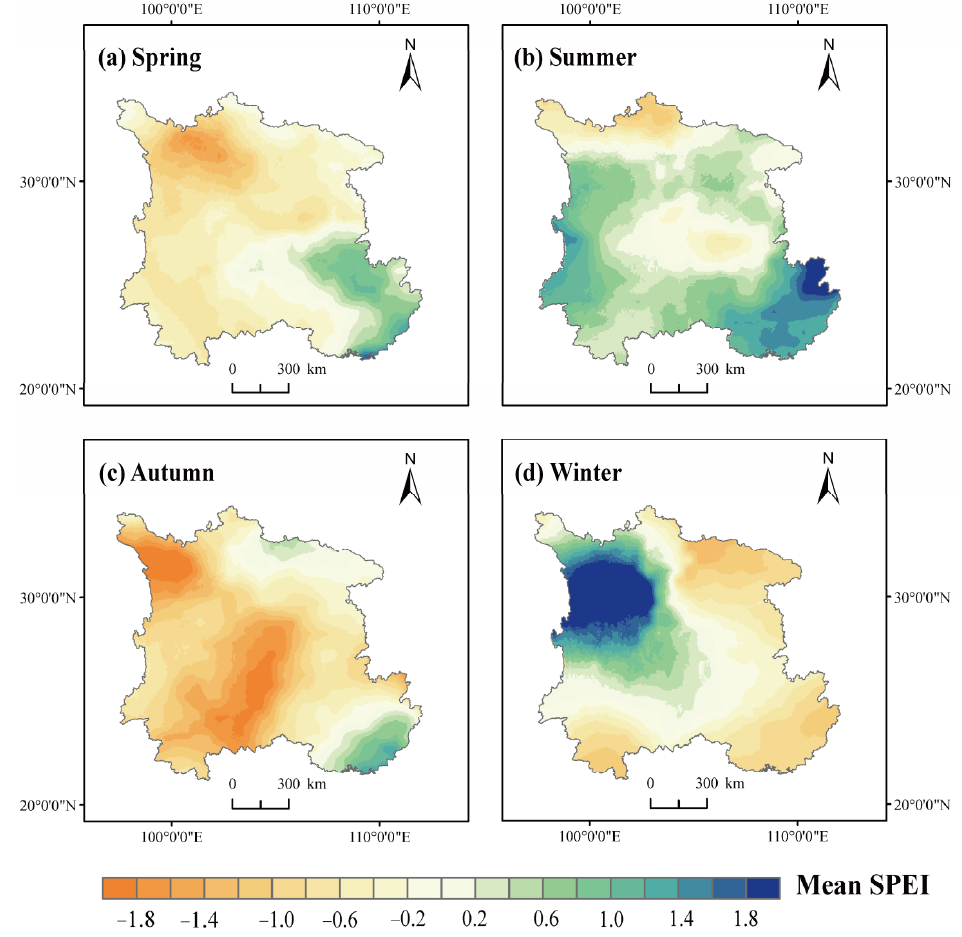
Figure 11. Spatial distribution of mean SPEI from 1990 to 2018. ( a ) Spring; ( b ) summer; ( c ) autumn; ( d ) winter.